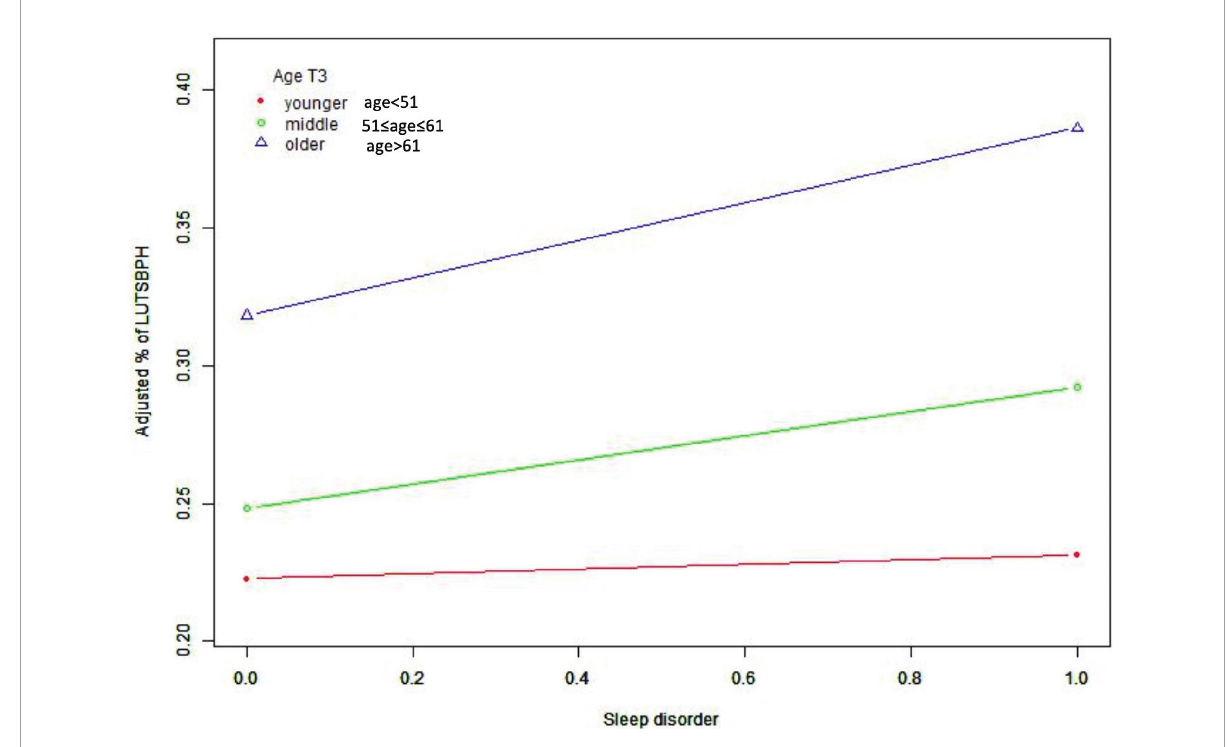
FIGURE3 Smooth curve fitting of sleep disorder and risk of LUTS/BPH, grouped by age.